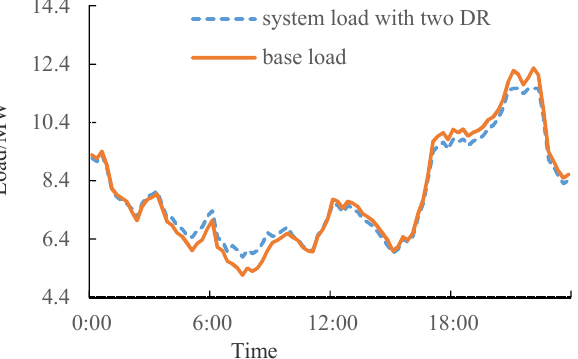
Figure 9. Comparison of load profile between base loads and loads with DR taken into account.